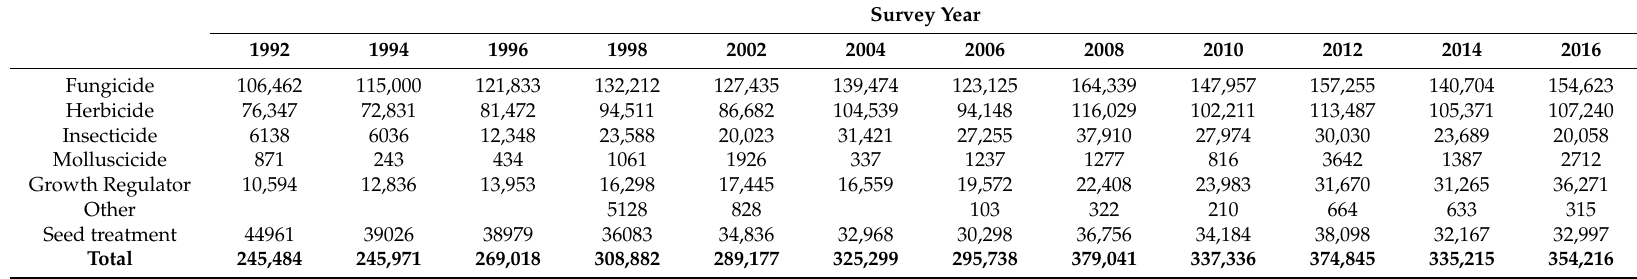
Table 4. The area of arable crops treated (sp.ha.) with the major pesticide groups in Northern Ireland 1992–2016.